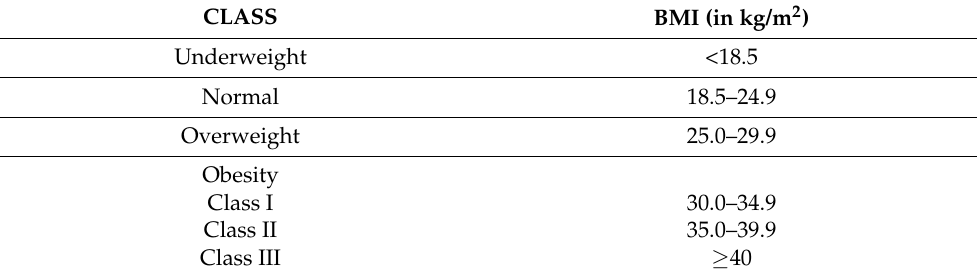
Table 1. Categorization for